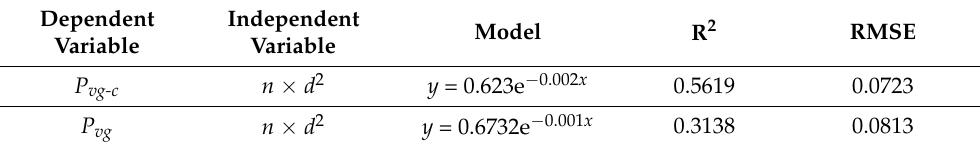
Table 3. Statistical models of P vg and P vg-c estimation using n × d 2